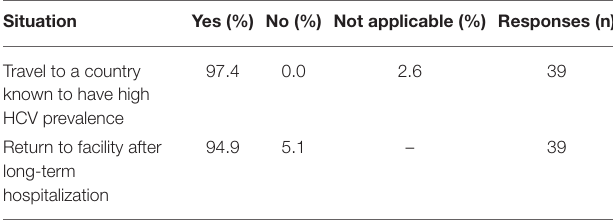
TABLE 14 | HCV education and screening of dialysis staff members (China Medical Director HCV survey, 2021). Practice Prevalence (%) Staff HCV screening frequency